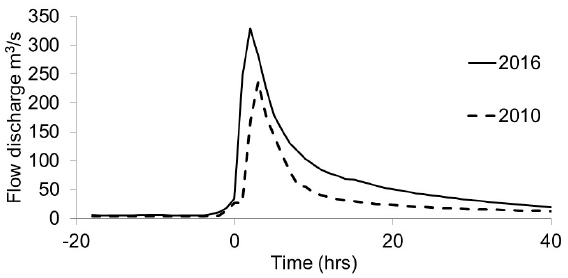
Figure 2. ( a ) and ( b ) Aerial photos of Kyusen Bridge (43°35’59.0” N 142°37’00.1” E) before and after the 2016 flood. ( c ) and ( d ) Close up views from the right and left banks, respectively.